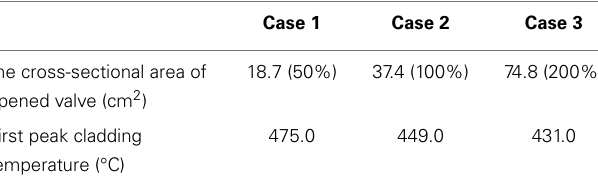
Table 2 | Sensitivity analysis on depressurization rate